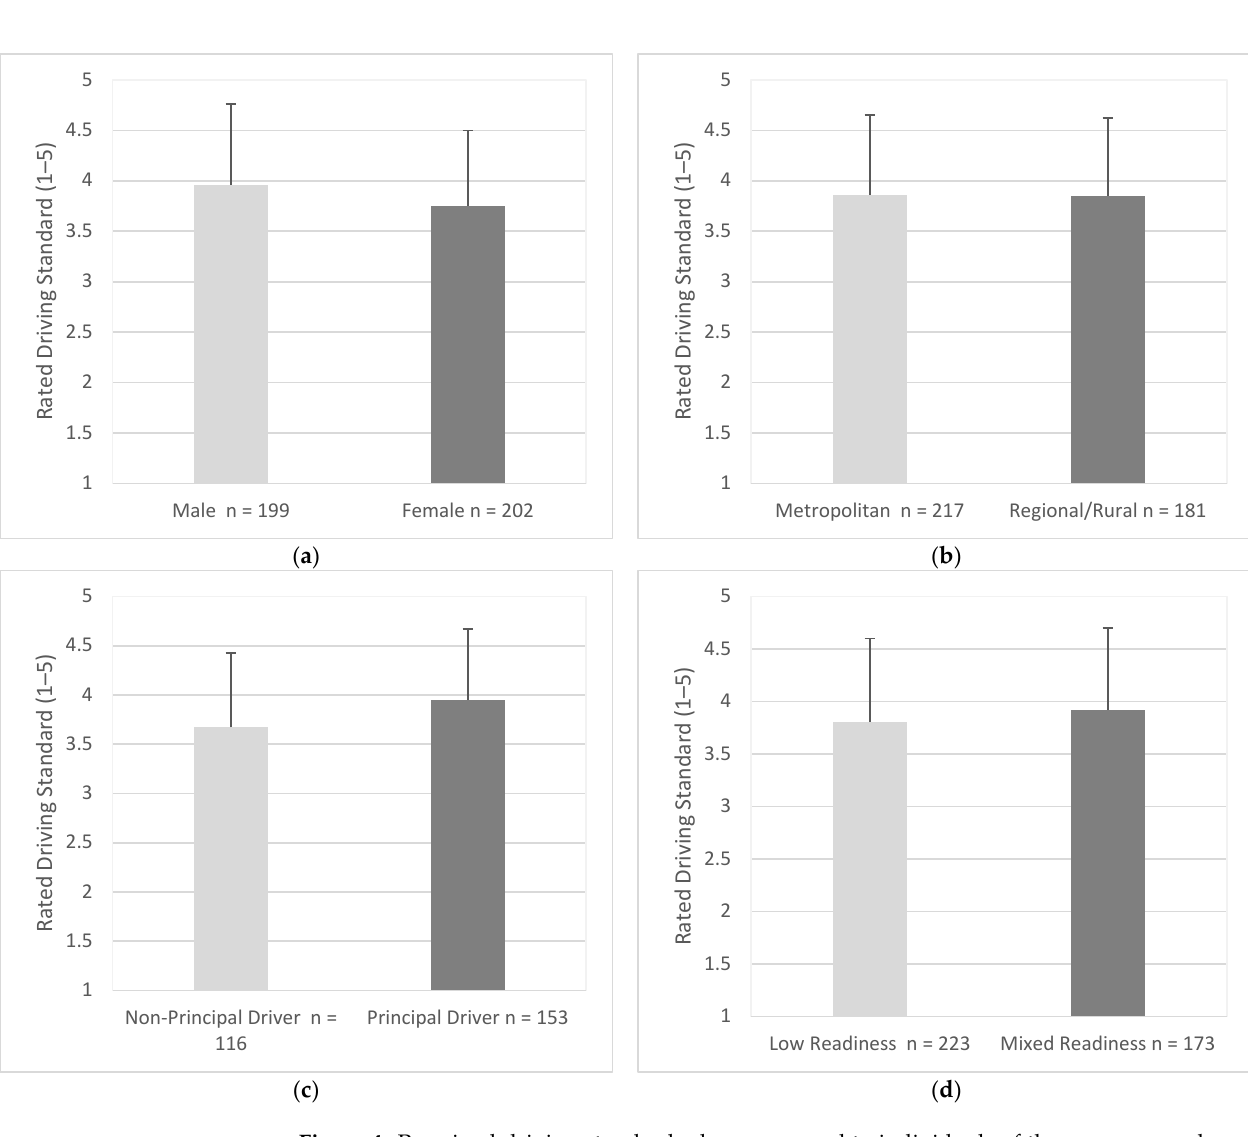
Figure 4. Perceived driving standard when compared to individuals of the same age and gender as endorsed by participants in each group; ( a ) Gender, ( b ) Residential Area, ( c ) Driving Roles, ( d ) Readiness. Responses were measured using responses of 1 (much worse) to 5 (much better). Error bars represent standard deviation.